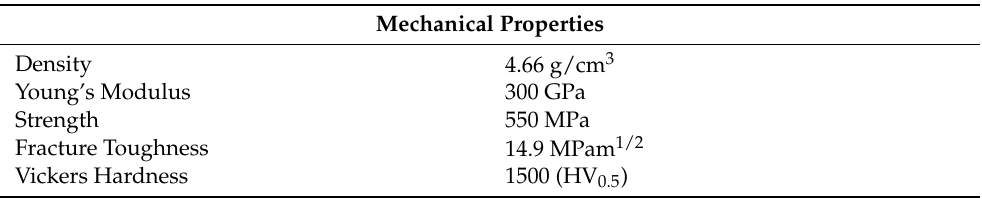
Table 3. Material properties of an experimental grade composite material, using cerium oxide as stabilizing oxide for zirconia.